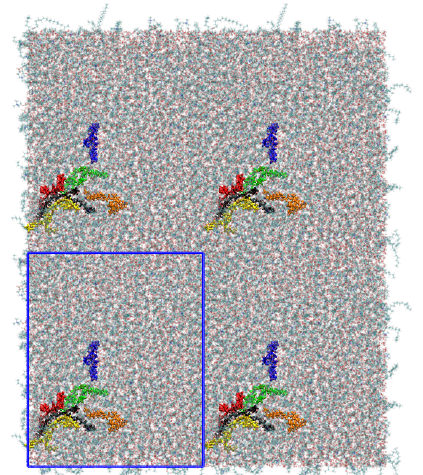
Figure 6. Snapshot of the top view onto the system showing the clustering of the B16/10 molecules. Namely the red, yellow and black colored molecules form a cluster, whereas the green and orange molecules are surrounding the cluster. Compared to Figure 3 (same coloring of the molecules), one can see that the cluster exchanges the molecules within the simulation. The simulation cell dimensions are shown as blue